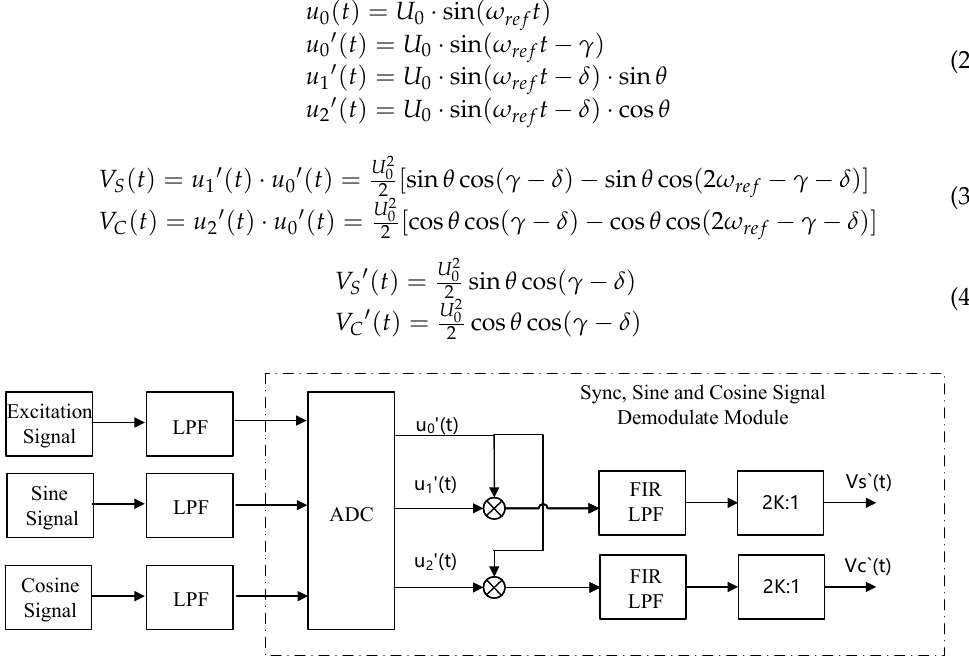
Figure 3. Synchronization, sine and cosine signal demodulation module method